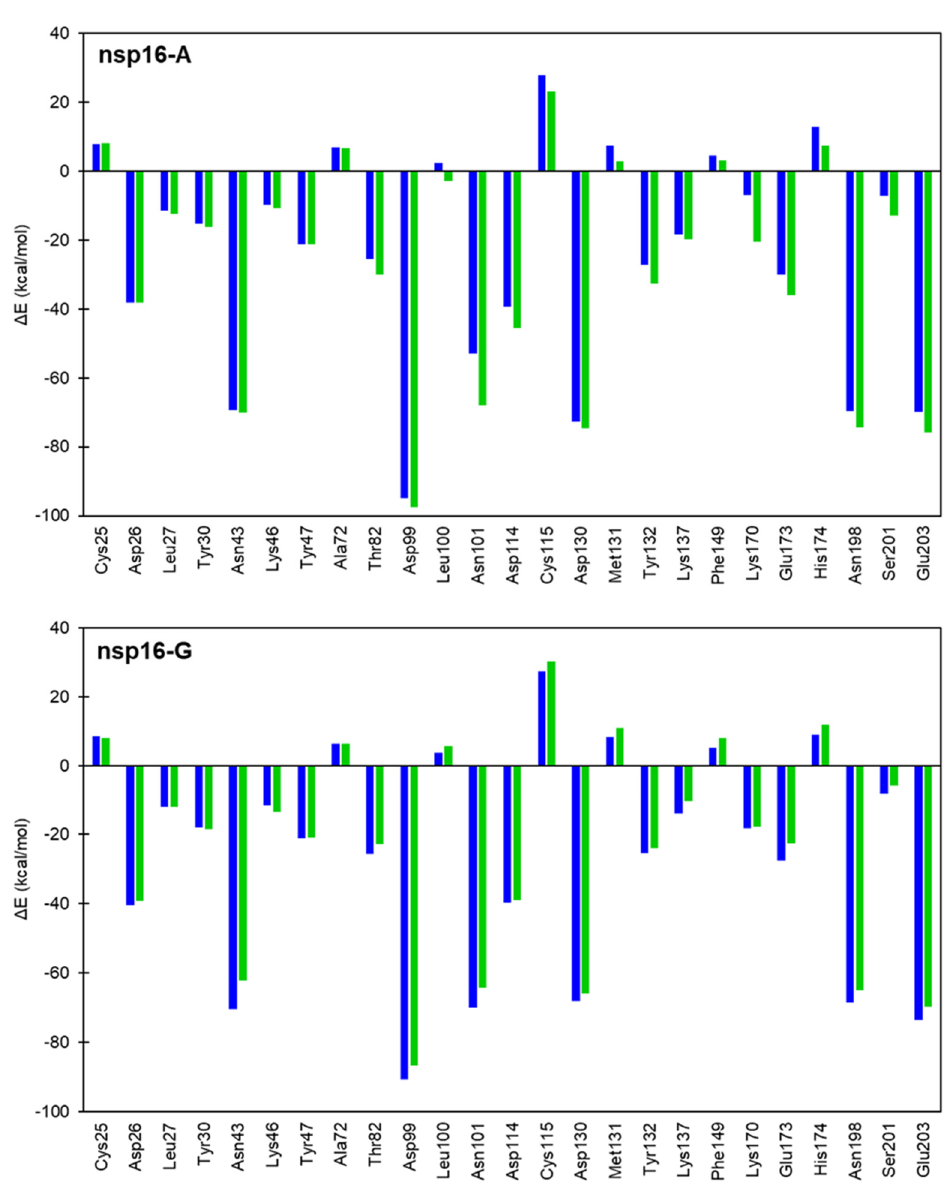
Figure 6. TS (green color) and RS (blue color) stabilization (negative values) or destabilization (positive values) effects of the most relevant active site residues on the nsp16-A and nsp16-G systems at DFTB3/MM